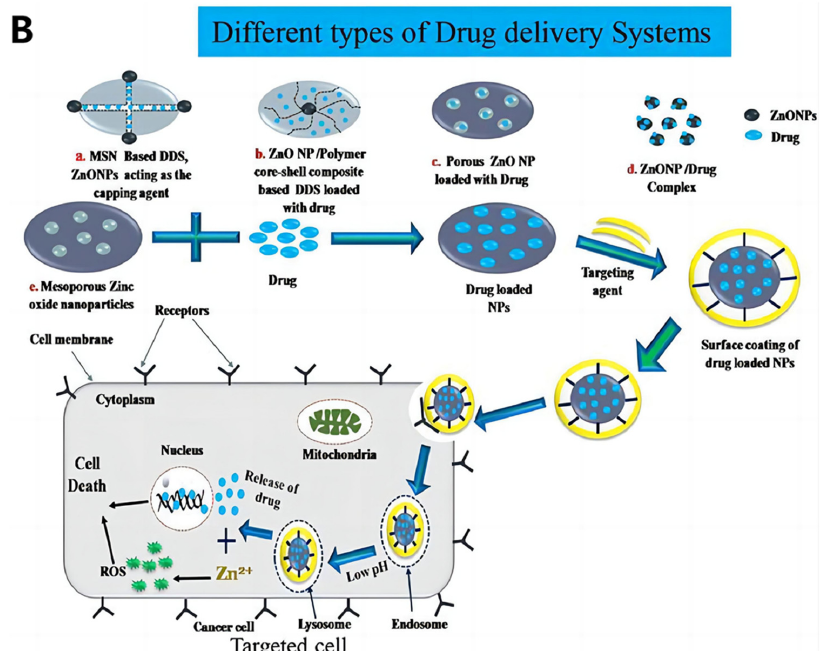
Figure 3. ( A ) Possible anticancer mechanisms of ZnONPs: Following internalization into cancer cells, ZnONPs produce Zn 2+ ions via dissolution under acidic intracellular environments and cause oxidative stress. The increased ROS cause mitochondrial dysfunction and activate the intrinsic apoptosis pathway. ROS can also cause cell death via extrinsic apoptosis and necrosis pathways. ROS further induce oxidative DNA damage and mitotic death. ROS can also trigger autophagic or mitophagic cell death. ( B ) ZnONPs as anticancer drug delivery carriers; mesoporous silica nanoparticle-based DDS, where acid-sensitive ZnONPs are used as pore-blocking agents after drug loading inside channel-like pores; ZnO/polymer core–shell nanocomposite, where drugs are loaded within the hydrophobic shell; porous ZnONPs, where drugs are loaded inside the pores; ZnONP/drug complex via stable coordination bonding between the Zn 2+ ions of ZnONPs and the oxygen-containing functional groups of the drug; porous ZnONPs loaded with drug enter the cells via endocytosis and release the drug into the cytosol after passing through the lyso- some. ZnONPs also impart a synergistic anticancer effect due to the production of highly toxic Zn 2+ ions in weakly acidic intracellular microenvironments. Abbreviations: DDS, drug deliv- ery system; ROS, reactive oxygen species. Reproduced with permission [103]. Copyright © 2020 Elsevier